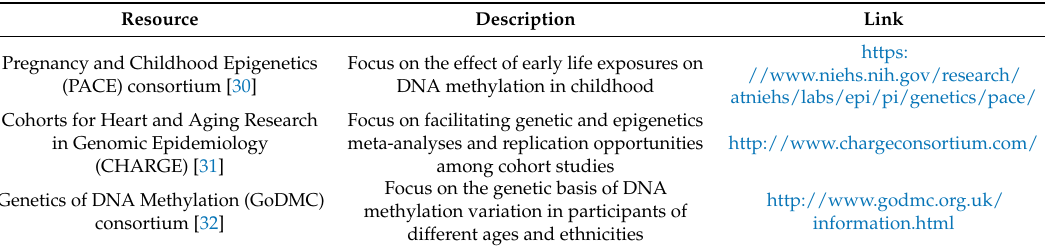
Table 2. Selection of consortia in the field of epigenetic